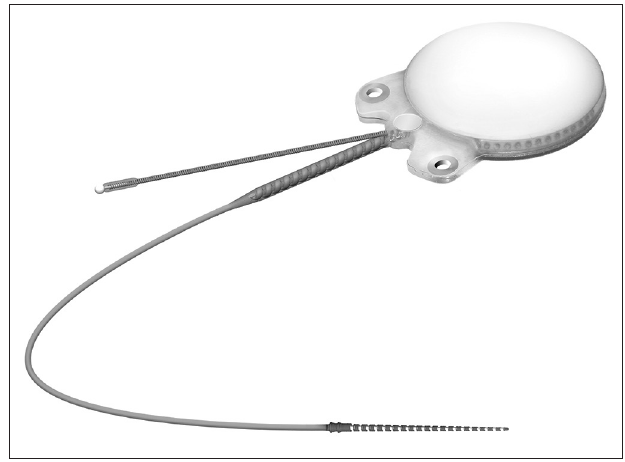
Figura 1. Ilustração mostra o componente interno onde há o receptor, estimulador e região magnética, numa pequena estrutura de cerâmica selados numa base de titânio. Atente para o nicho lateral dos dois parafusos fixadores - Digisonic ® SP desenvolvido pela